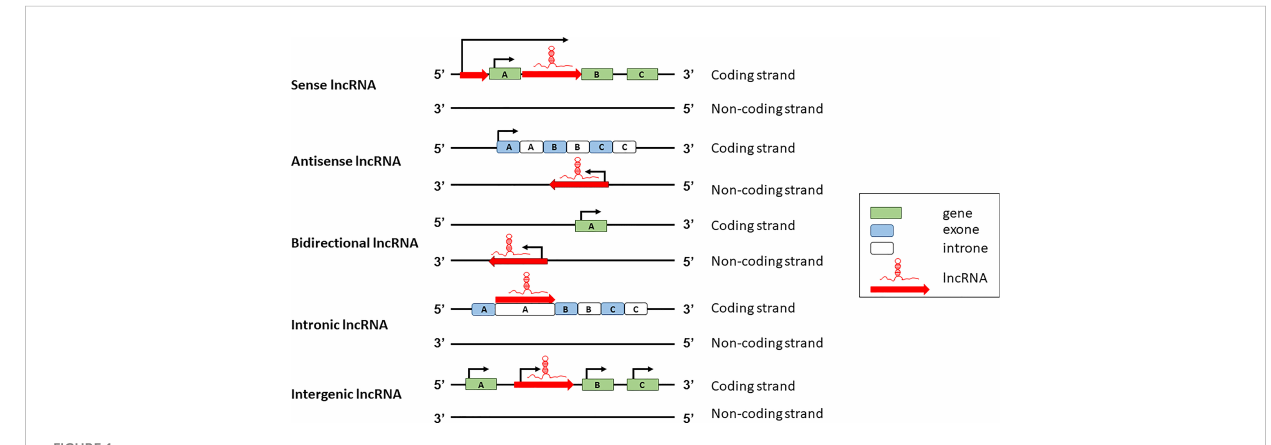
FIGURE 1 Classi fi cation of lncRNA based on genomic structure and